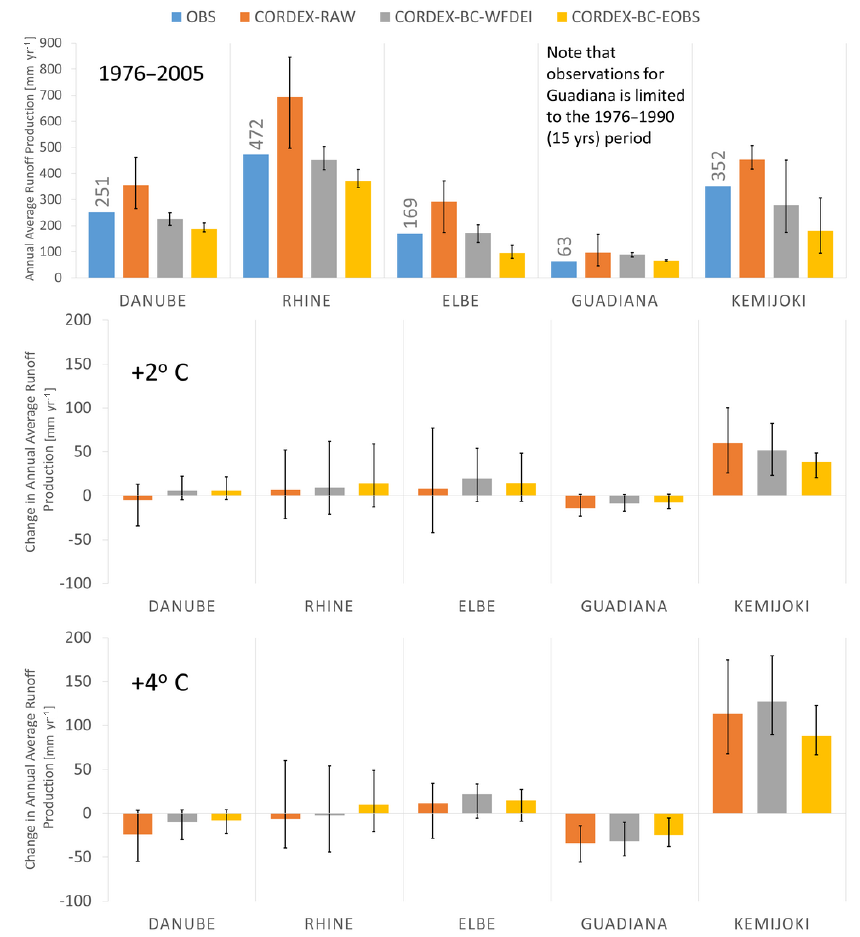
Figure 10. Comparison between the simulations of raw Euro-CORDEX data and bias adjusted against two different data sets (WFDEI and E-OBS) for five study basins. Bars show the ensemble means and error bars the minimum and maximum ensemble member values. Top row panels: annual average runoff production for the period 1976 to 2005. OBS values are derived from GRDC discharge measurements converted to basin averages at the annual timescale. Middle row panels: percent change in annual average runoff production at the + 2 SWL; and bottom row panels: at the + 4